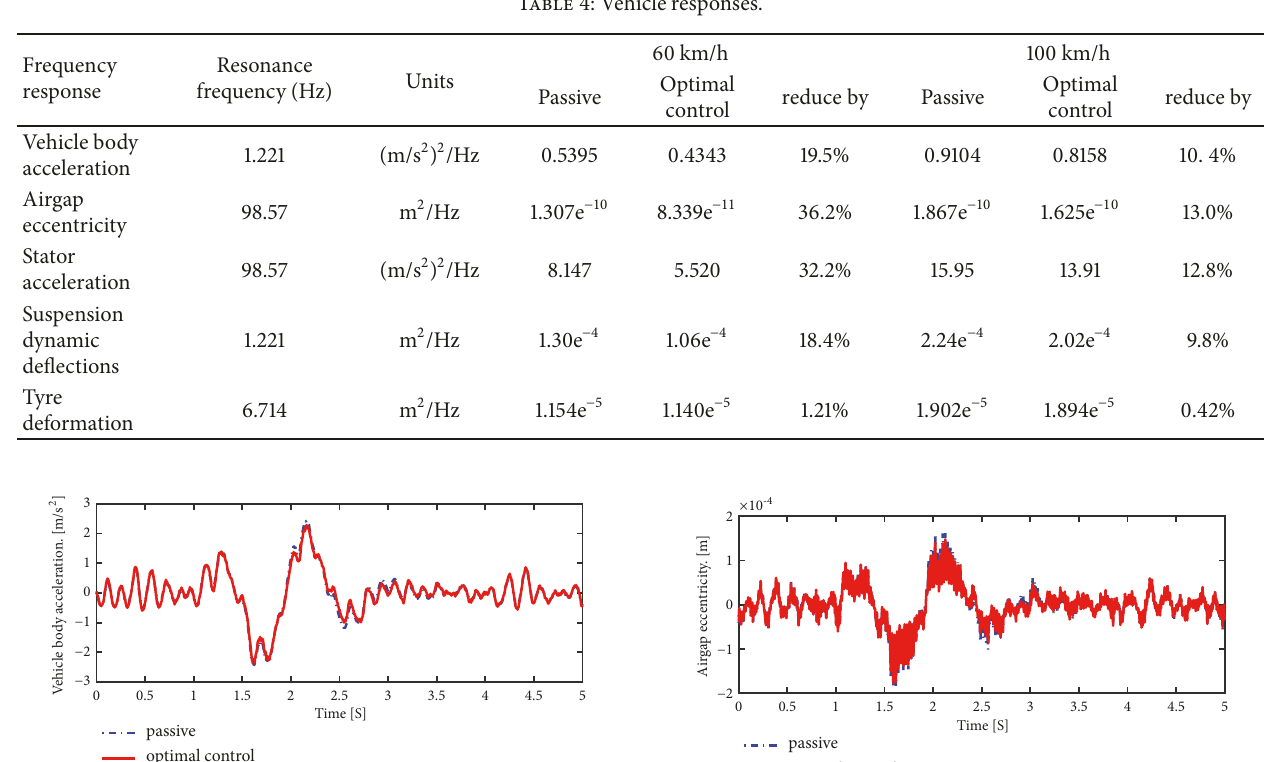
Table 4: Vehicle responses.